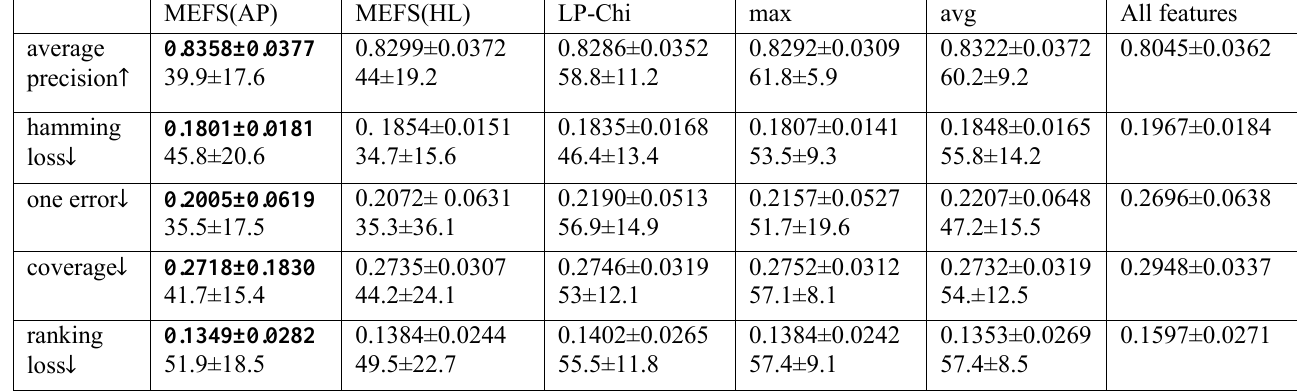
Table 3. Comparative results with classifier